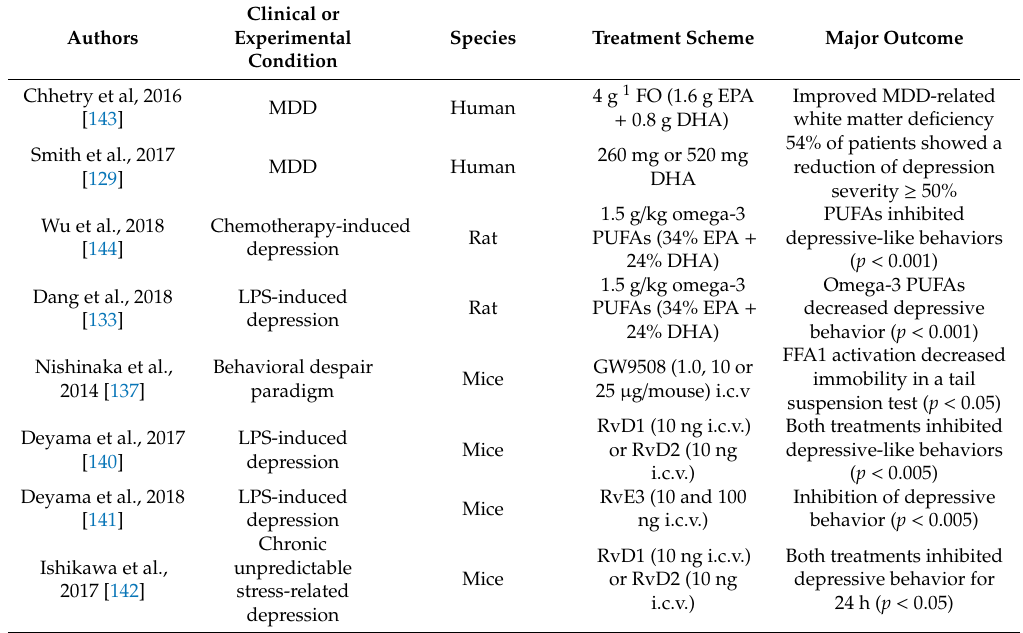
Table 3. A brief summary of the selected articles using omega-3 PUFAs as treatment for